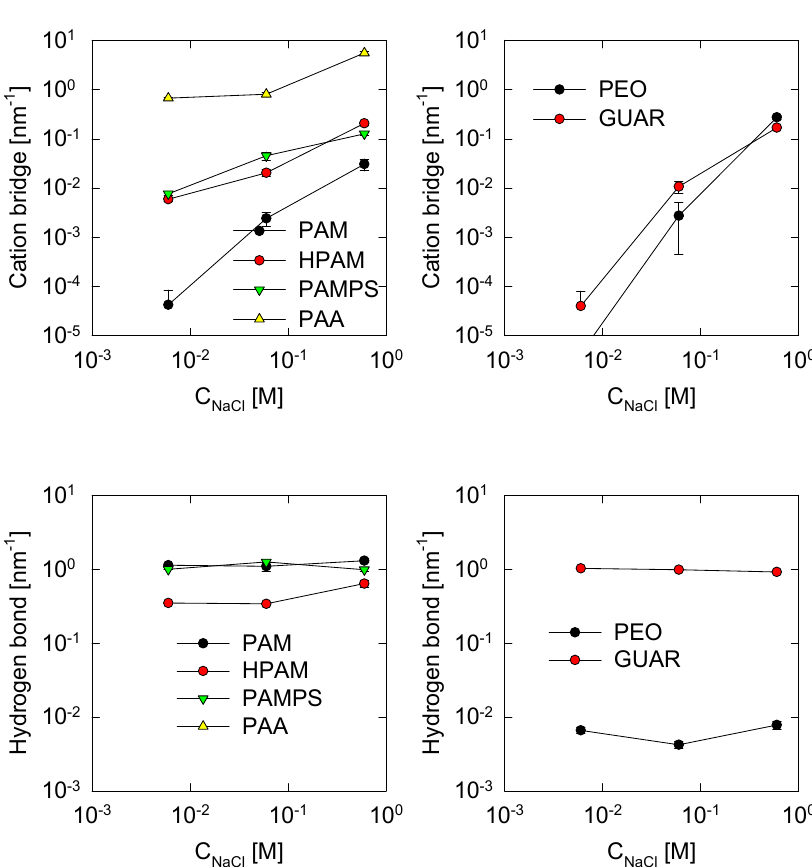
Figure 7. Polymer self-cation bridge and hydrogen bond interactions for all systems studies.